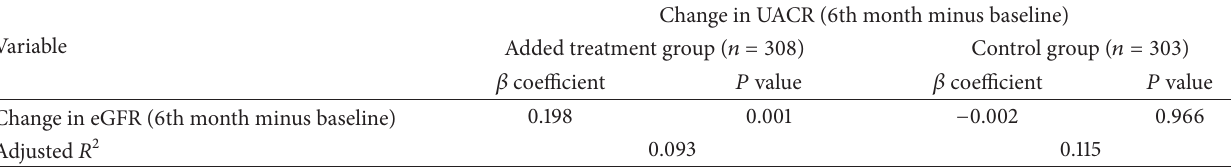
Table 4: Factors associated with change in